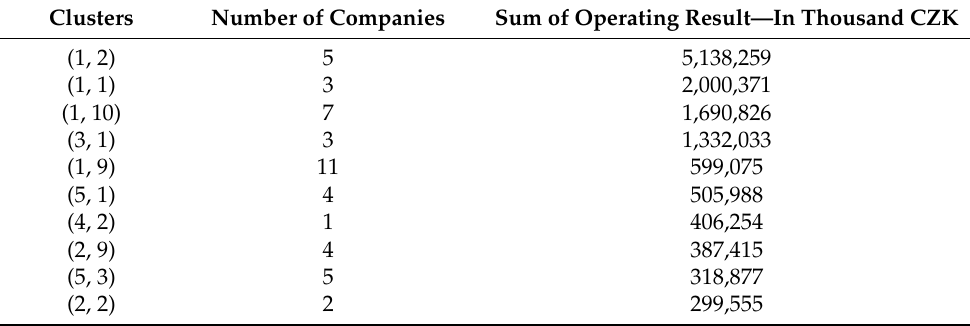
Table 24. Table of ten clusters with the highest sum of OR for the year 2018. Clusters Number of Clusters